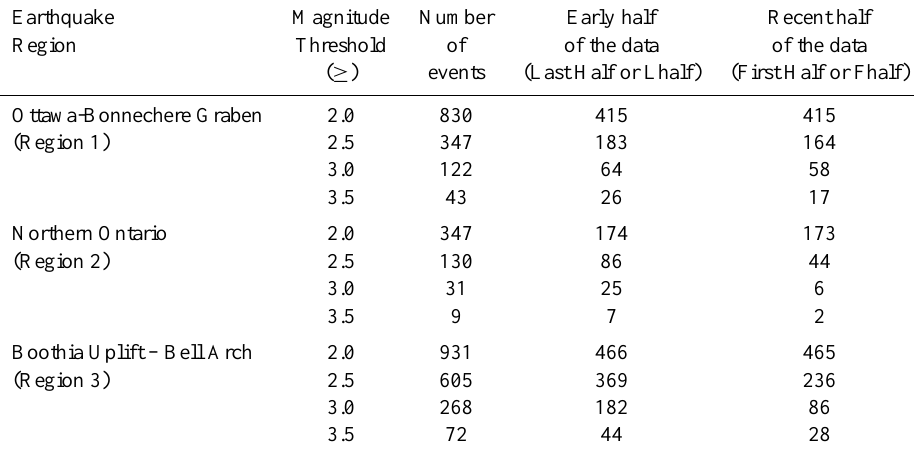
Table 2. Number of events according to the magnitude. Ratio of time-interval of the recent half (First Half) to that of the early half (Last Half) for three regions studied: a) Region 1: 0.92 b) Region 2: 0.47; c) Region 3: 0.17. We used the event catalogue from July 1990 to July